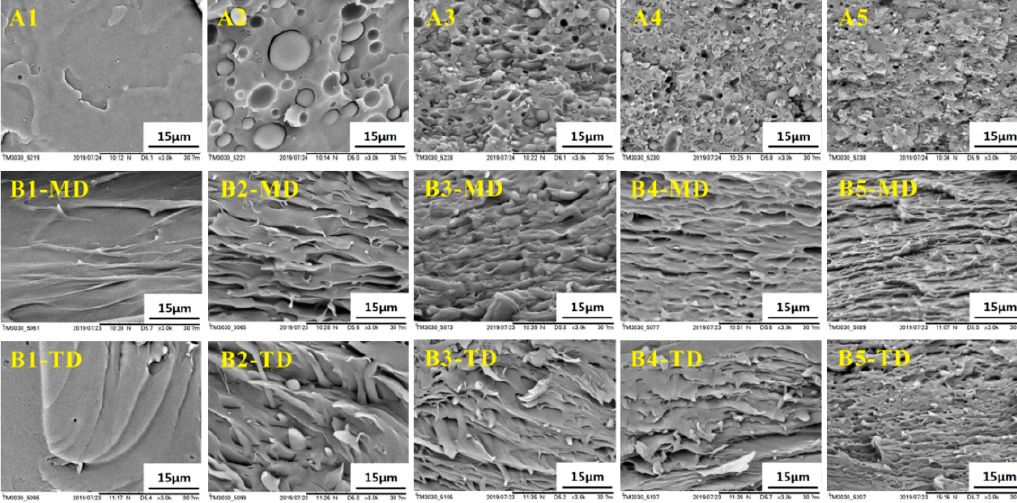
Figure 3. SEM images of PLLA and PLLA / EPDM / OMMT (90 / 10 / x) samples prepared by ( A ) compression-molding / ( B ) calendering ( 1 -Neat PLLA, 2 -90 / 10, 3 -90 / 10 / 1, 4 -90 / 10 / 2, and 5 -90 / 10 / 4).